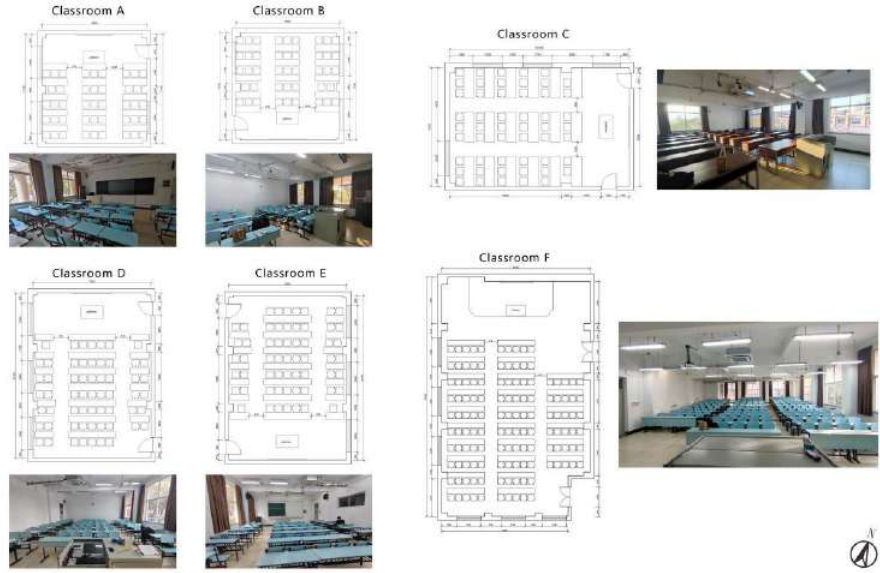
Figure 4. Plans/photos for the studied classrooms: (1) classrooms A and B = small-sized classrooms;